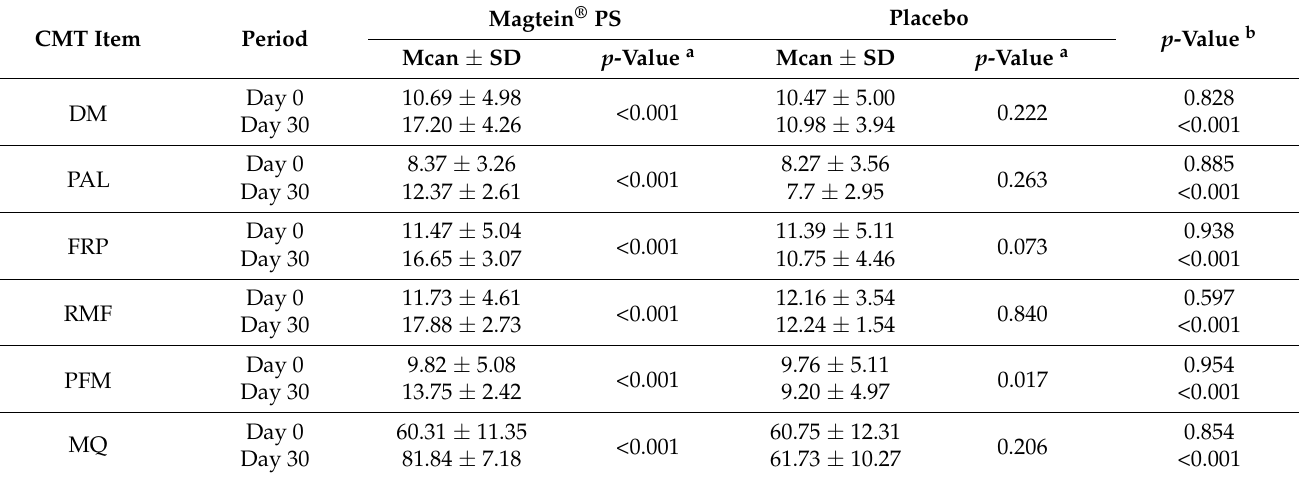
Table 4. Effects of Magtein PS and placebo on CMT Scores and MQ score by treatment.